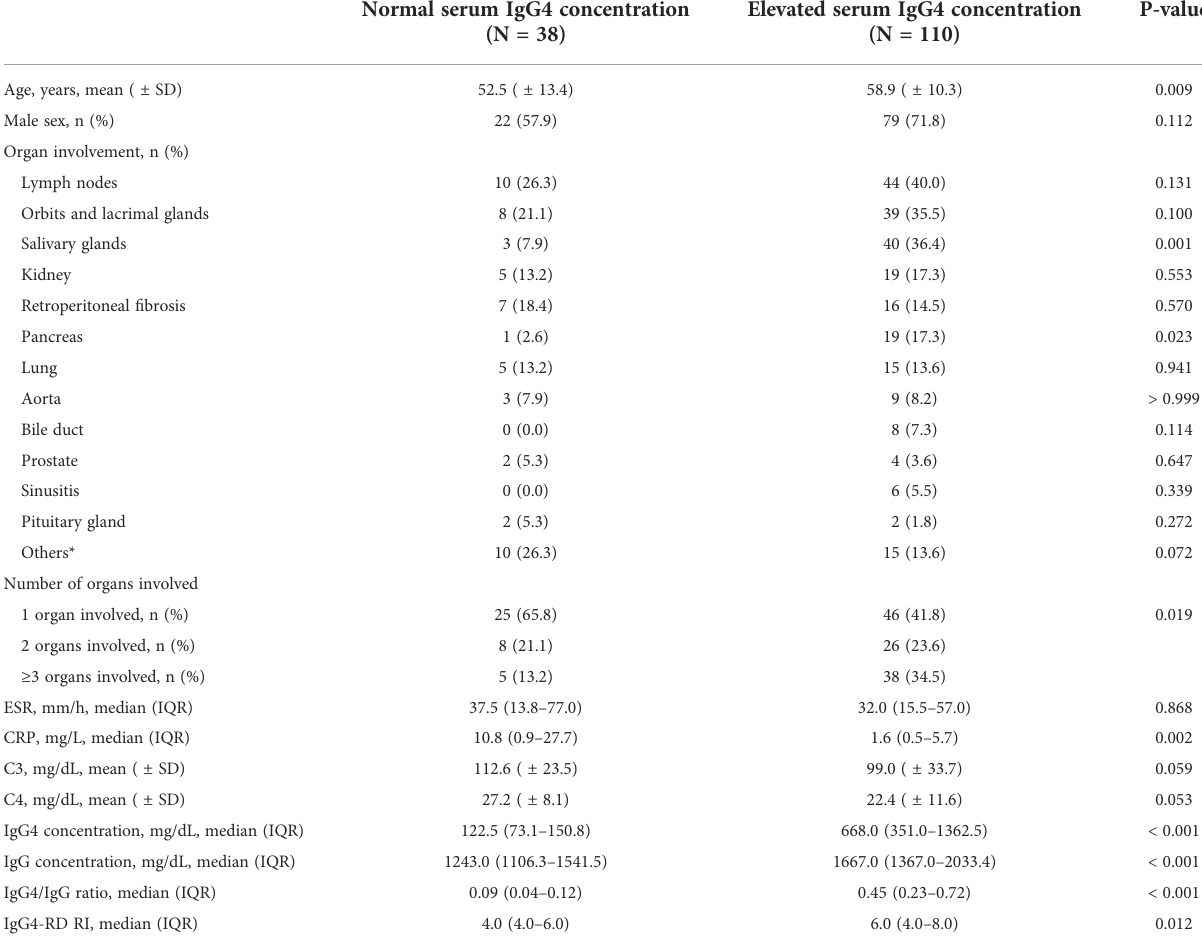
TABLE 2 Comparison between patients with normal and elevated serum IgG4